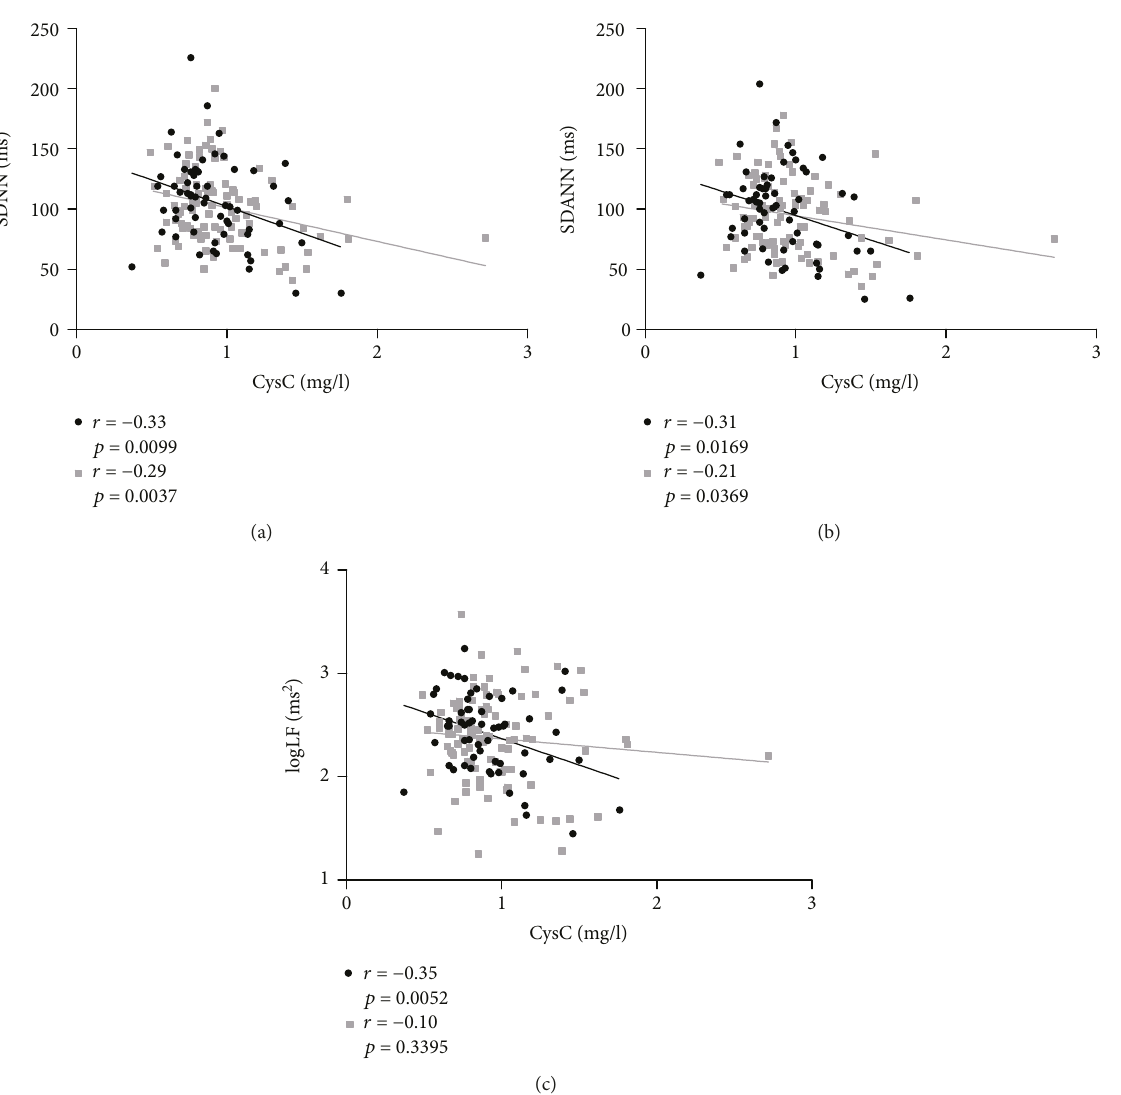
Figure 3: Relationship between cystatin C (mg/l) and HRV indexes in men (black circle) and women (gray square). Correlation assessed by Pearson analysis. (a) Cystatin C (mg/l) with SDNN (ms), (b) cystatin C (mg/l) with SDANN (ms), and (c) cystatin C (mg/l) with logLF (ms 2 ).